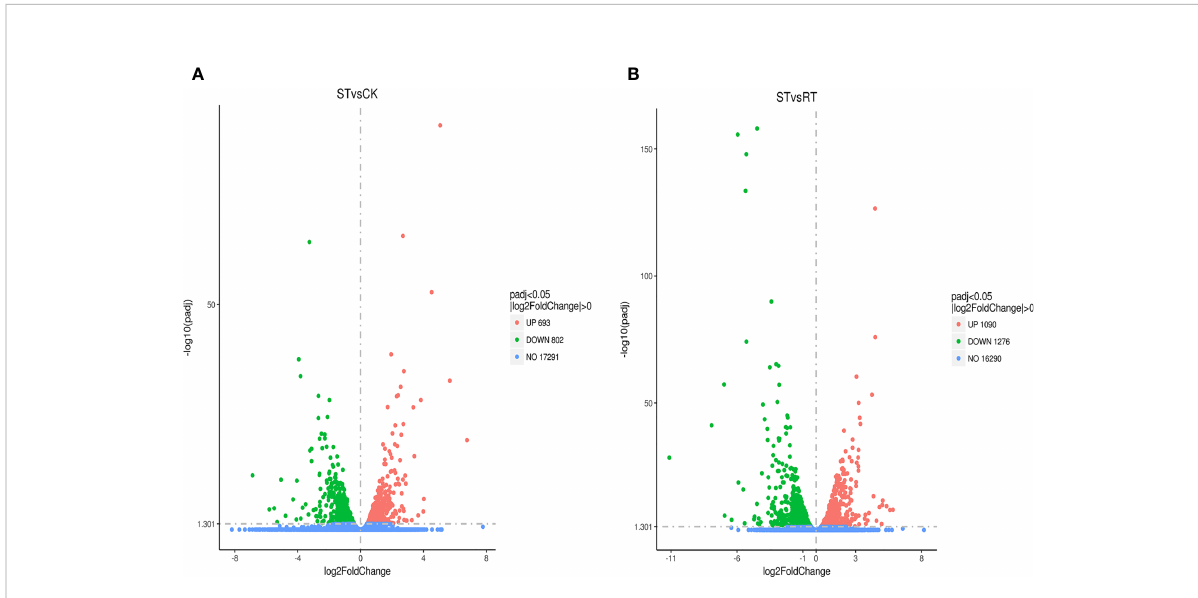
FIGURE 6 Differential gene statistics. (A) Volcano map of differential genes between the control group and starvation group; (B) Volcano map of differential genes between the refeeding and starvation